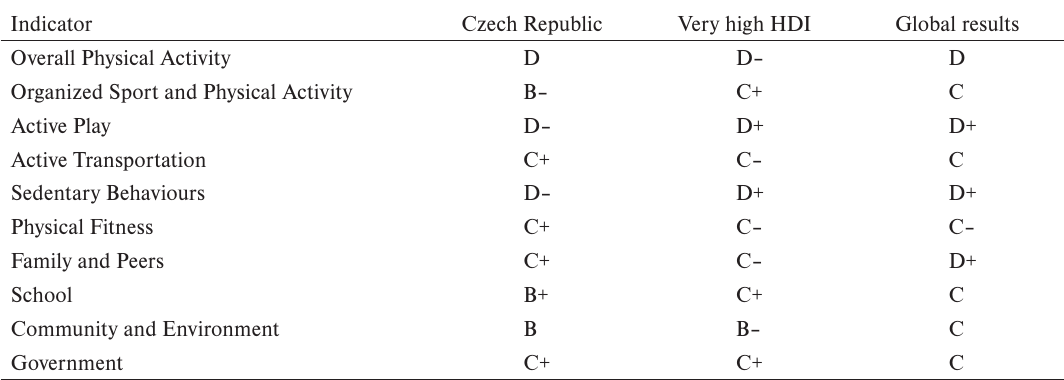
Grades by physical activity indicators in the 2018 Report Card for Czech Republic and comparisons with average grades from a group of high Human Development Index (HDI) countries and global averages